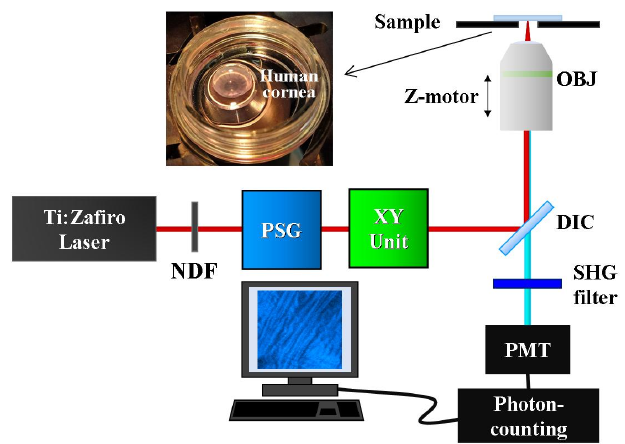
Figure 1. Sketch of the SHG microscope used for imaging human corneas. NDF, neutral density filter; PSG, polarization state generator; DIC, dichroic mirror; OBJ, objective; PMT, photo-multiplier tube. The inset corresponds to a specimen ready to be imaged.